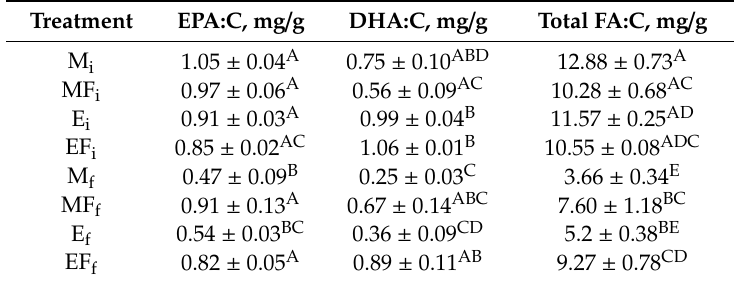
Table 7. Results of one-way ANOVA comparing means ( ± SE) of content of indicators of nutritive quality of zooplanktoninexperimentalmesocosmsatthebeginningandendoftheexperiment: